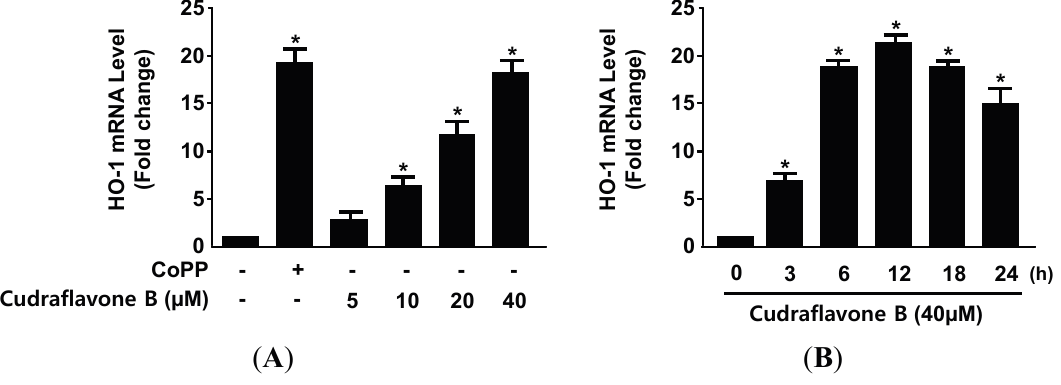
Figure 3. Effects of cudraflavone B on HO-1 mRNA ( A , B ) and protein ( C , D ) expression in HT22 cells. HT22 cells were incubated with indicated concentrations of cudraflavone B for 12 h ( A , C ) and cudraflavone B (40 μ M) for the indicated times ( B , D ). Data are presented as the mean ± SD values of three independent experiments. CoPP (20 μ M) was used as the positive control. * p < 0.05 vs.